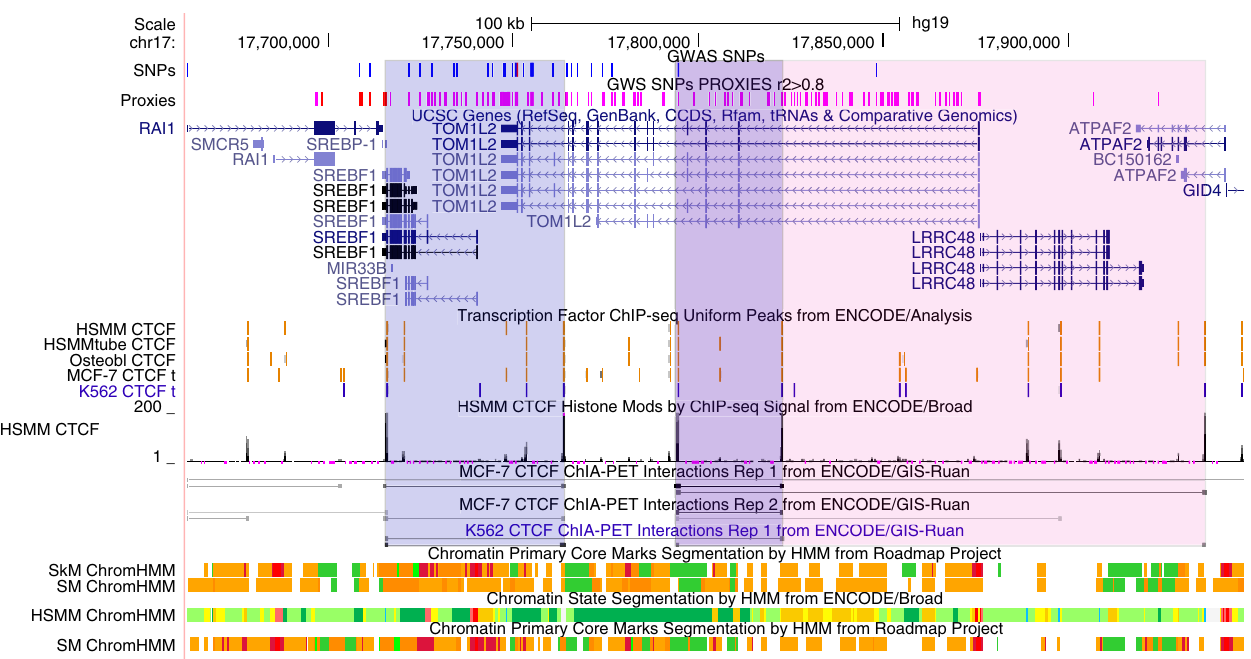
Fig. 3 17p11.2 locus displaying binding peaks and interaction tracks by CTCF ChIA-PET data together with histone marks based on chromatin state characterization. Predicted strong interactions shared in MCF-7 or K562 cell lines are shadowed in blue while a weaker interaction in both cell lines is shadowed in pink . These interactions overlap with predicted CTCF binding sites in osteoblast, myoblast and myotubes, hypothetically localizing SNPs in TOM1L2 close to transcribed regions in SREBF1 and A TPAF2 . Histone markers in muscular cells display high representation of associated SNPs in active enhancer predicted regions. Chromatin states are de fi ned as follows, Bright Red : Active Promote, Orange : Strong enhancer, Yellow : Weak/poised enhancer, Blue : Insulator, Dark Green : Transcriptional elongation, Light Green : Weak transcribed